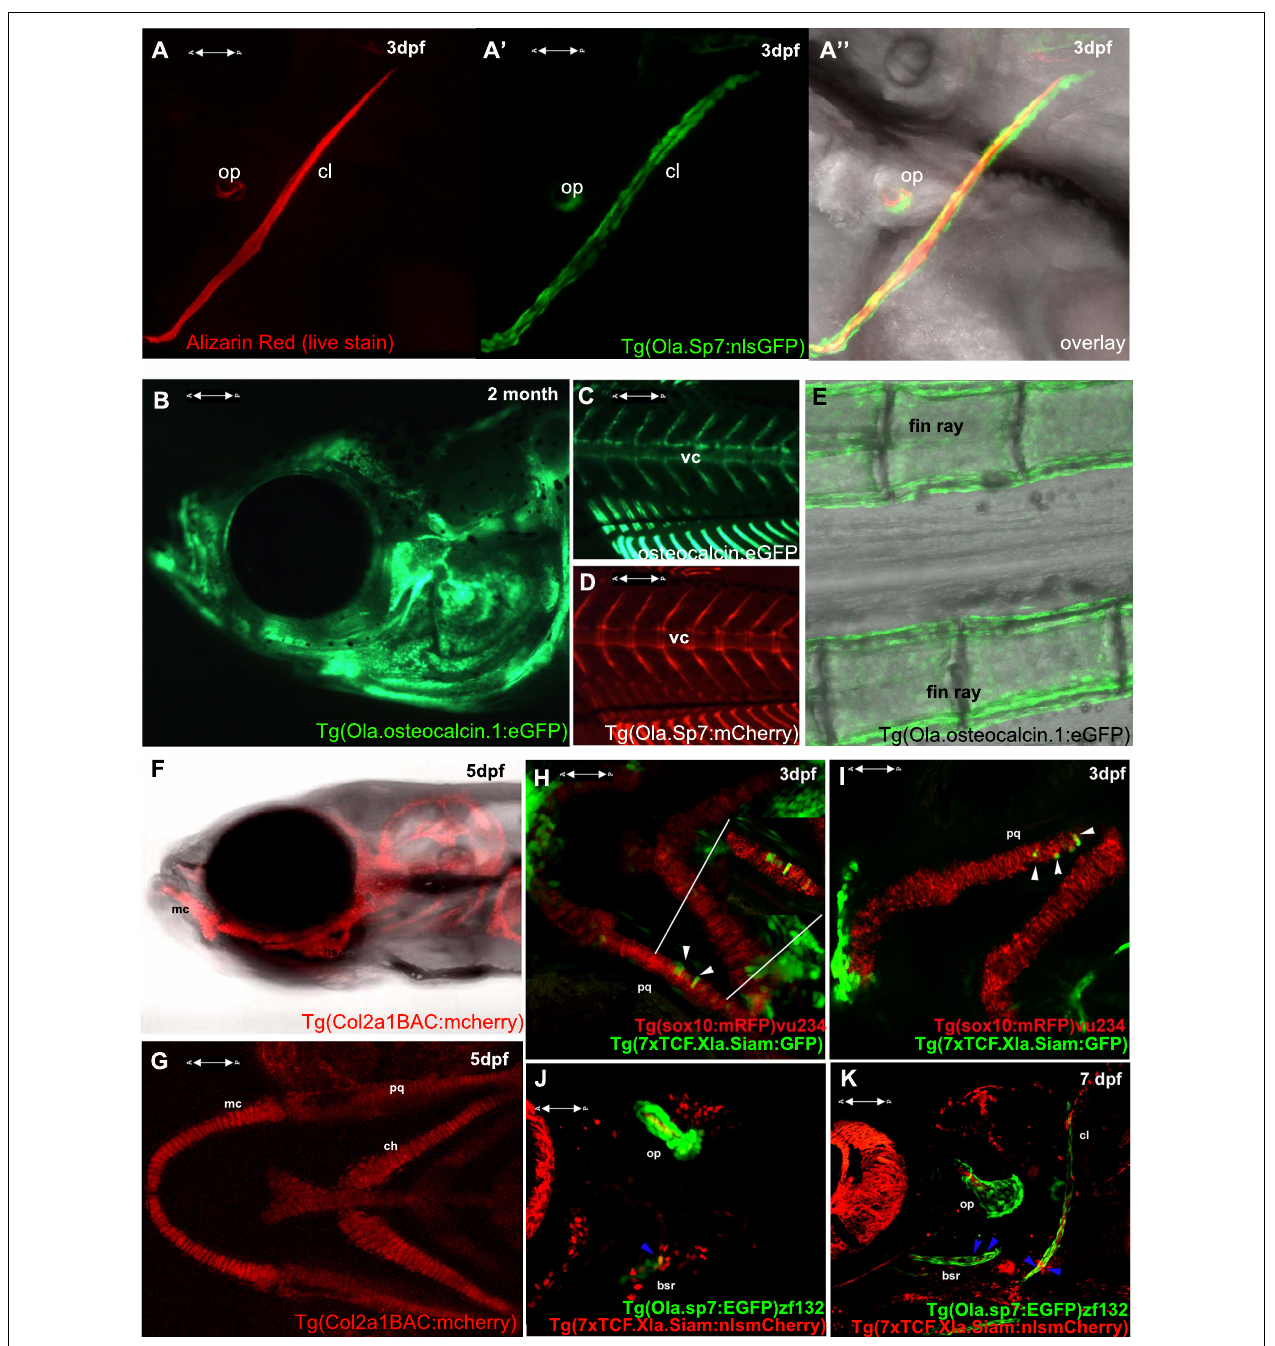
FIGURE 1 |Visualizing transgene expression in live fish during skeletogenesis. (A) Alizarin red live staining in a lateral view of a zebrafish at 3 dpf, A (cid:2) Osterix/sp7 activityTg(Ola.Sp7:nlsGFP)zf132 in the same fish. A (cid:2)(cid:2) overlay showing an Alizarin red-positive mineralizing core (red) surrounded by osteoblasts (green). (B) Osteocalcin/bglapTg(Ola.Osteocalcin.1:EGFP) hu4008reporter activity in the head of a 2-month-old zebrafish. (C) OsteocalcinTg(Ola.Osteocalcin.1:EGFP)hu4008activity in the vertebral column of a 19-day-old zebrafish. (D) osterix/Sp7Tg(Ola.Sp7:mcherry)zf131 activity in the same 19-day-old zebrafish as C. (E) Tg(Ola.Osteocalcin.1:EGFP) hu4008reporter expression in the caudal fin rays of a 2-month-old zebrafish. (F,G) Cartilage visualization in a 5-day-old zebrafish with a col2a1a reporter,